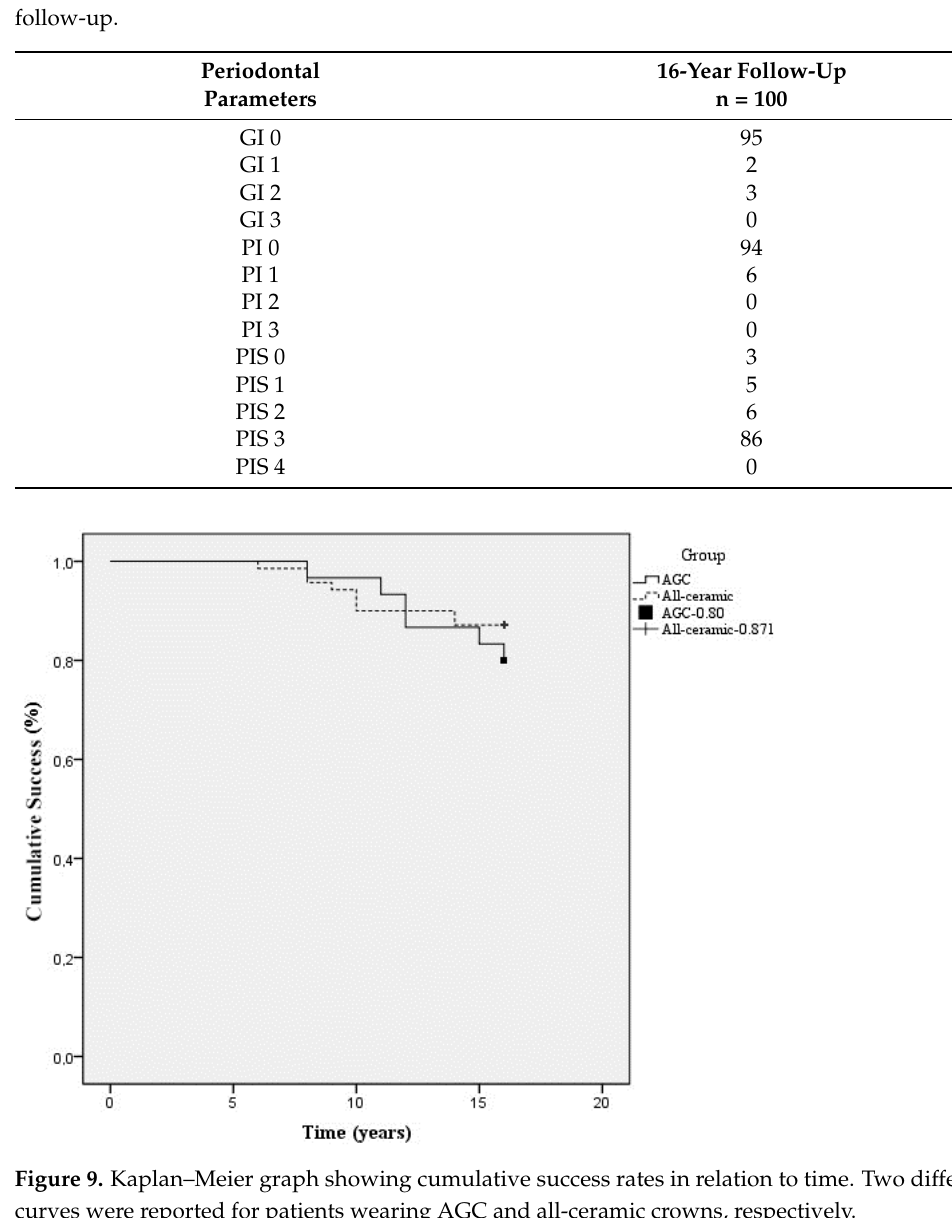
Table 2. Gingival Index (GI) score, Plaque Index (PI) score, and Papilla Index Score (PIS) at 16-year follow-up.